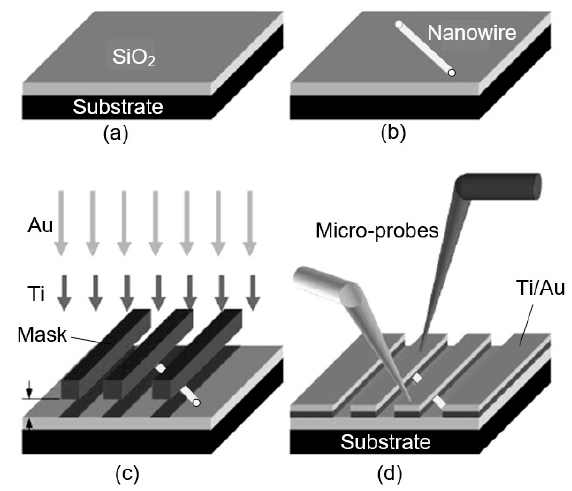
Figure 12. Protocol for a resist-free fabrication of 1D metal oxide nanowire-based chemiresistors and chemFETS: ( a ) Pristine Si / SiO 2 wafer; ( b ) nanostructures placed on wafer mechanically; ( c ) shadow masking to determine metal contacts; ( d ) microprobes can be used to explore transport and sensing properties of the individual nanoresistors. Idea from [234].